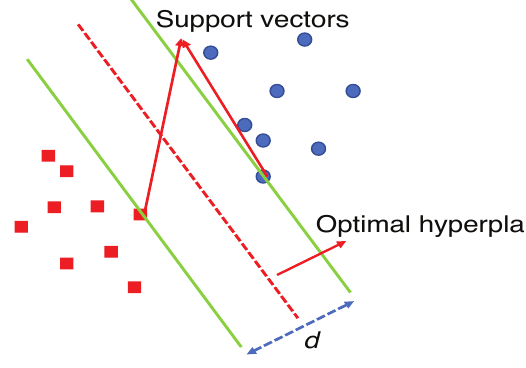
Figure 2. Optimal classification